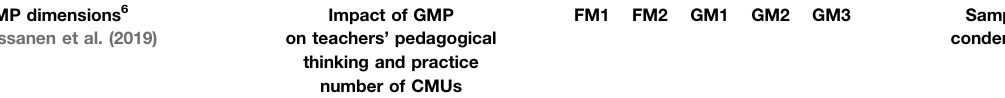
TABLE 3 | ( Continued ) Teachers ’ perceptions of the impact of GMP on their pedagogical thinking and practice.